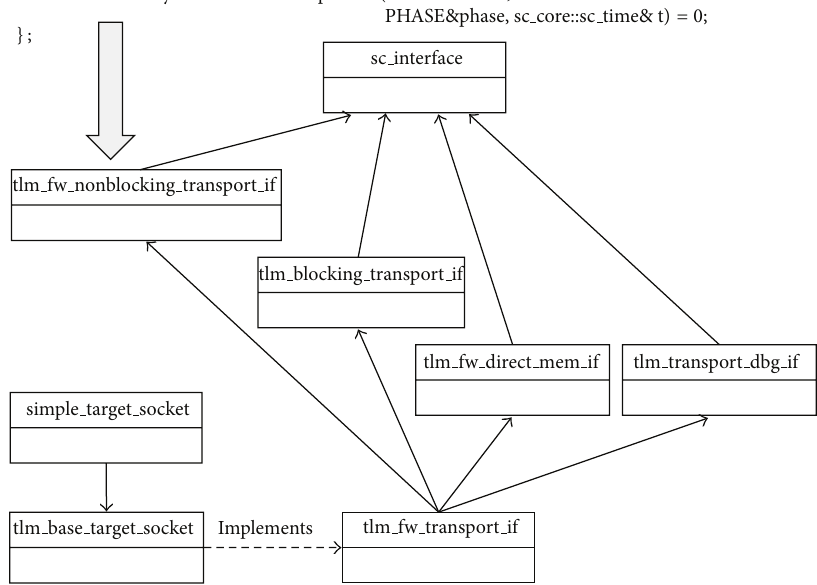
Figure 3: SystemC/TLM2 C++ forward interfaces